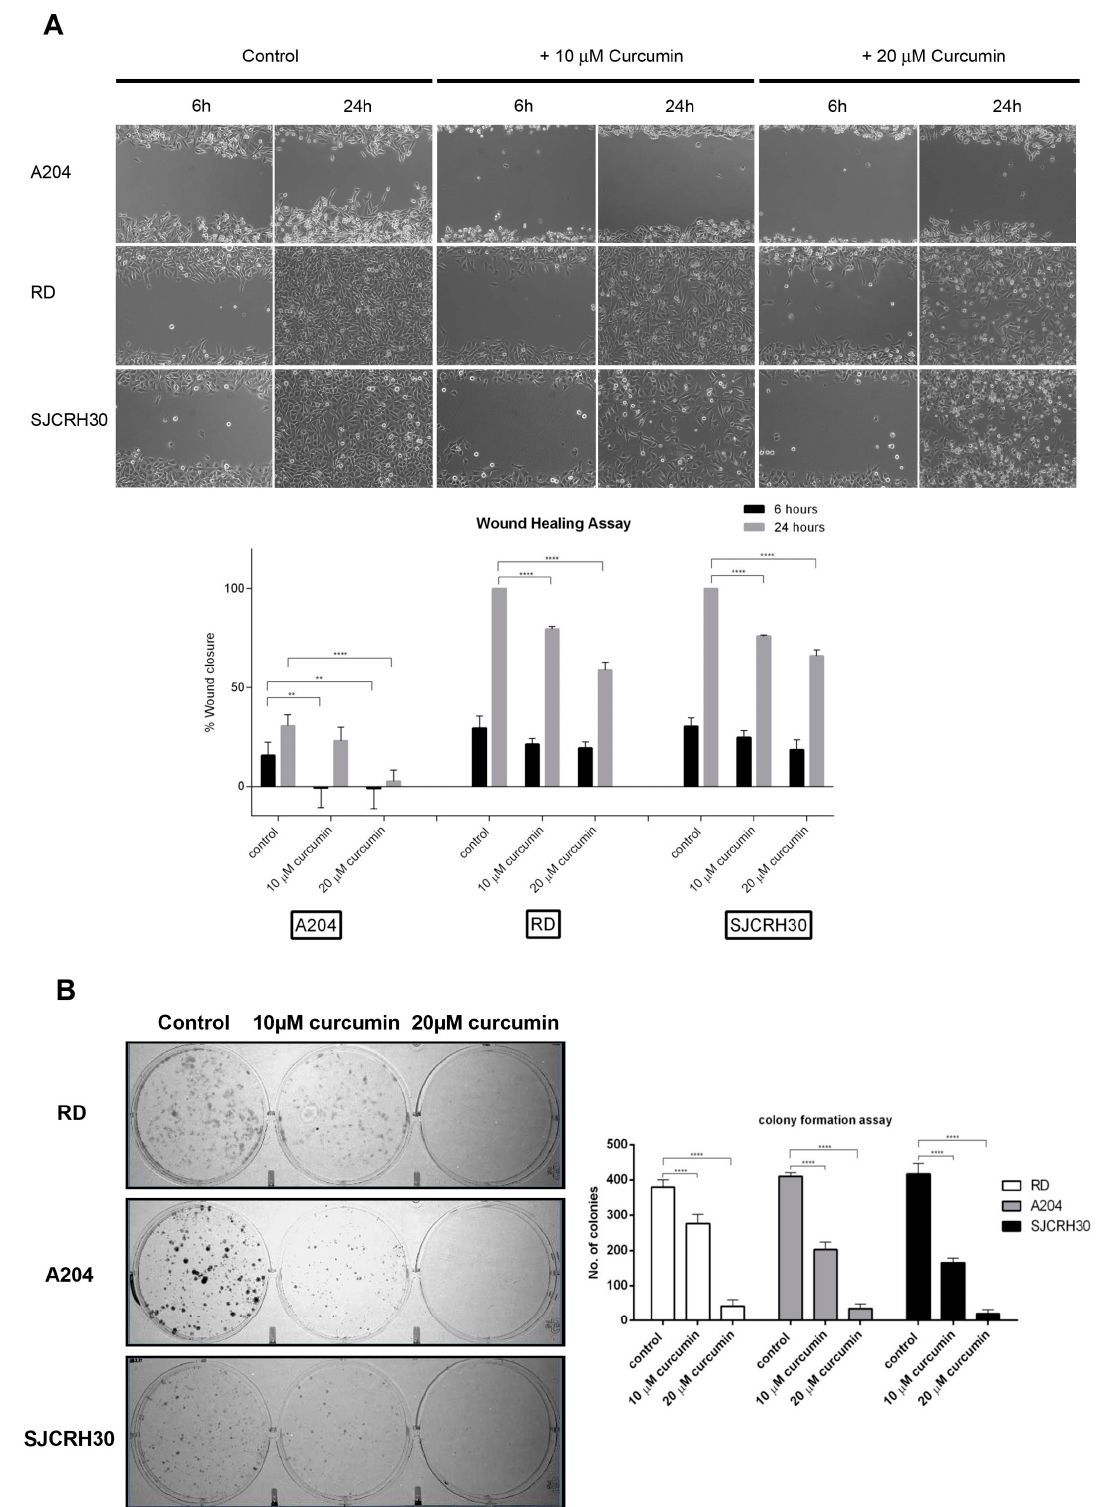
Figure 3. Curcumin influences rhabdomyosarcoma cell migration and colony forming ability. ( A ) Rhabdomyosarcoma cells (A204, RD, RH30) 90% confluence were “wounded” with a 200 µ L pipet tip. Three “wounds” were formed on each culture dish in duplicate per experiment. Loose cells were removed with washing and fresh complete medium containing vehicle (DMSO) or curcumin (10 or 20 µ M) was added to each cell monolayer. The “wounds” were photographed under light microscopy at 6 and 24 h after the initial “wounding”, and the diameters measured using the AxioVision software. Data were plotted as percent healing of the original “wound” and graphed using GraphPad